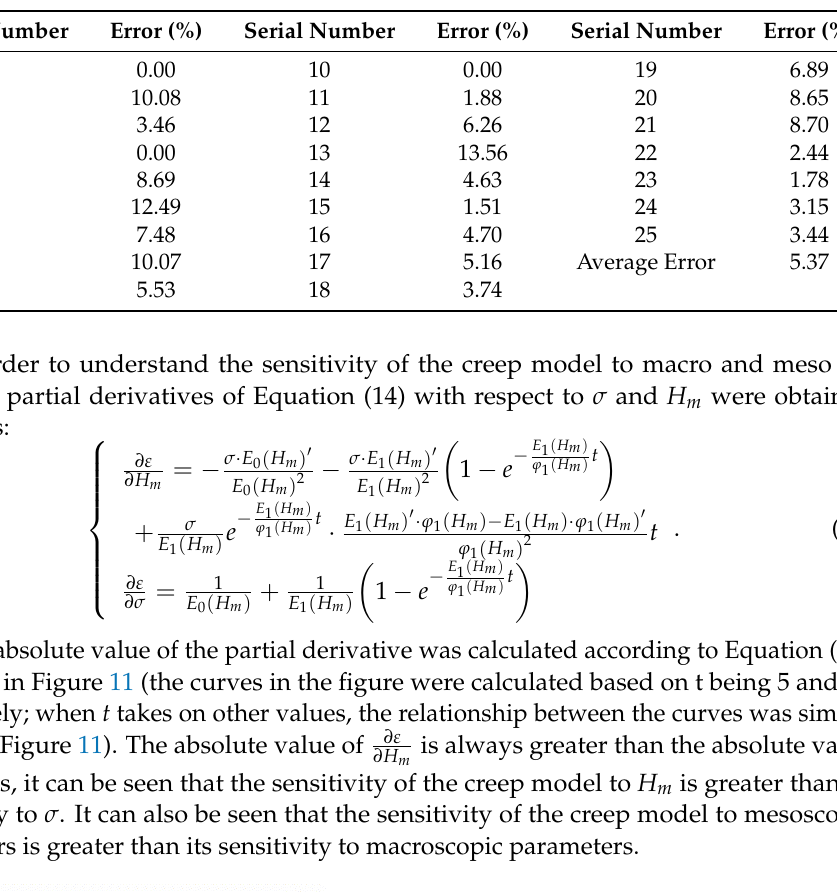
Figure 10. Validation of the model: ( a ) settlement curves for the measured and modeled settlement; ( b ) long-term creep deformation prediction of soft marine soil. Table 3. Relative errors between the measured and modeled settlement.